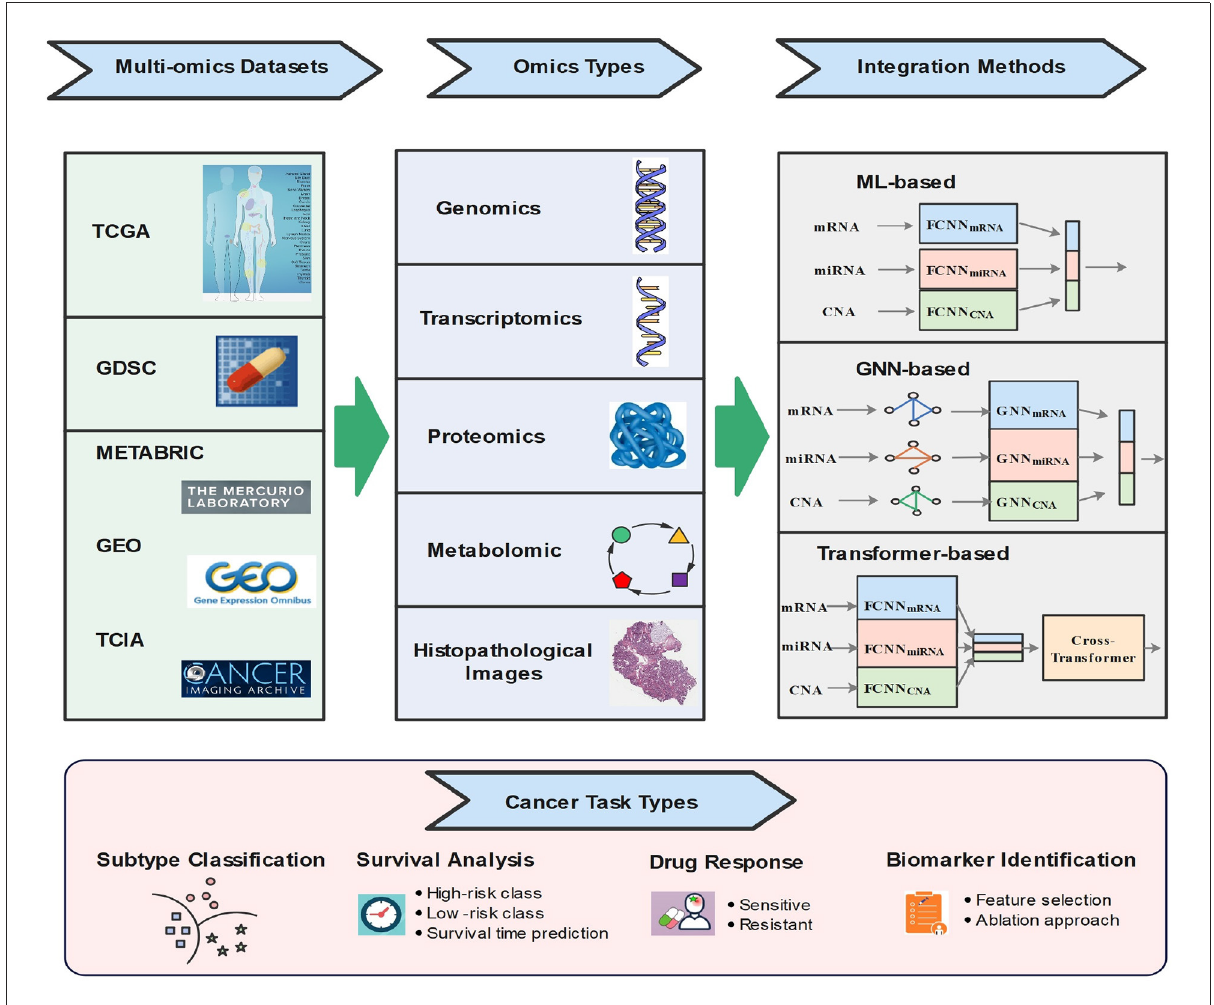
FIGURE2 Illustration of multi-omics-based data integration using machine